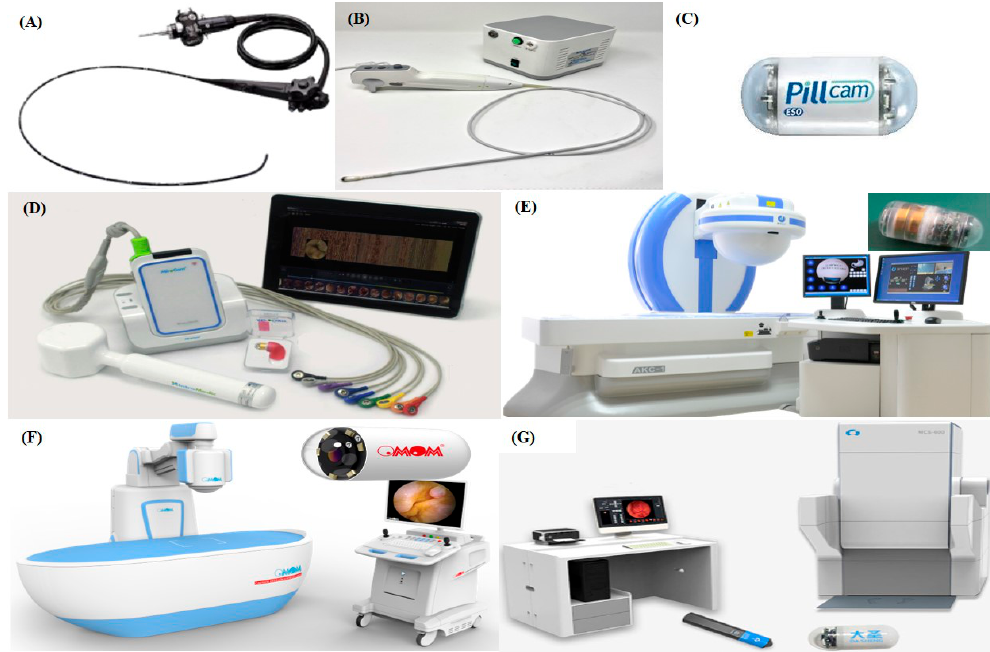
Figure 1. Commercially available gastroscopes: ( A ) Olympus gastroscope (courtesy of